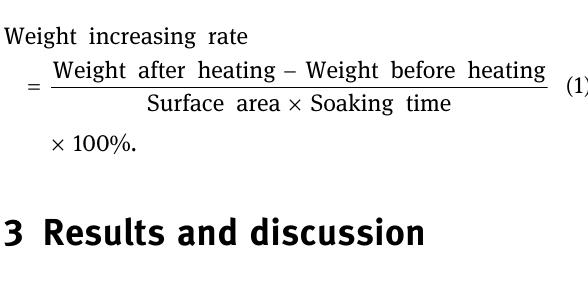
Figure 2: Heatingandhot stampingprocessofAl – Si – Cucoatingsample.